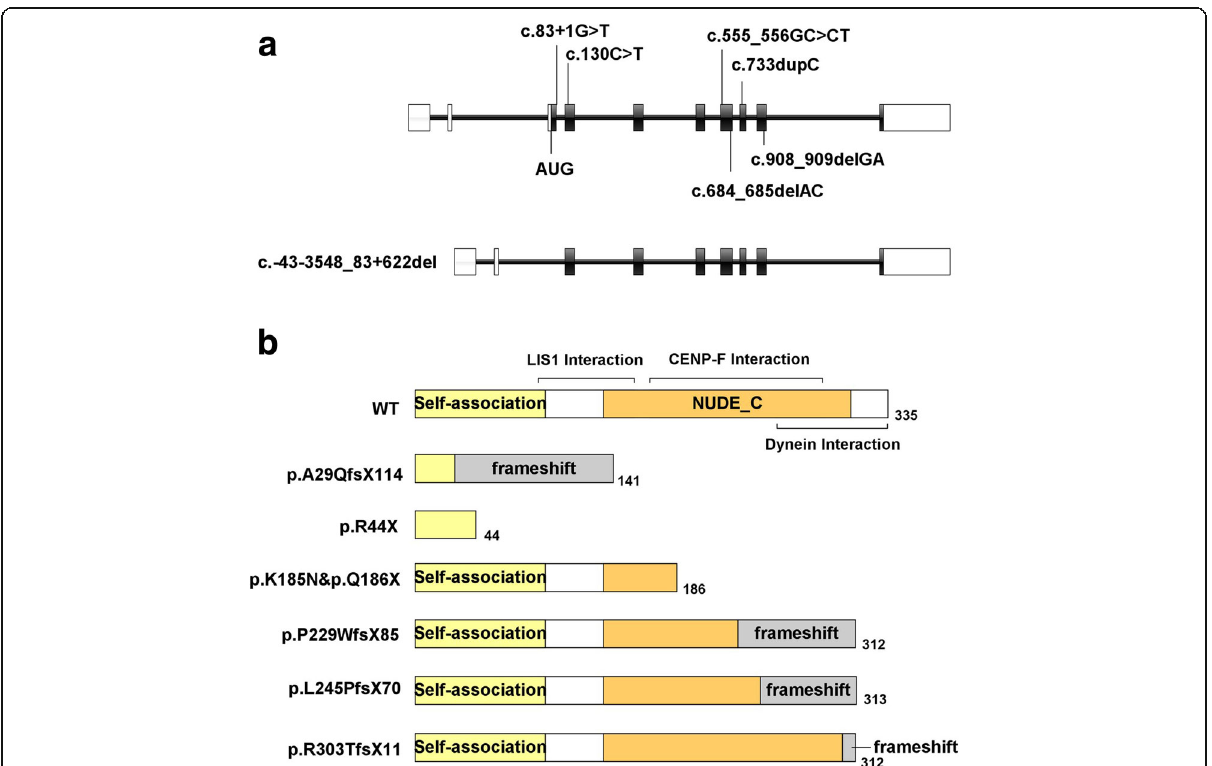
Fig. 2 The diagram of human NDE1 (NM_001143979.1). The coding sequences are shown in black and all the reported mutations are labeled ( a ). The predicted NDE1 protein derived from the mutations ( b